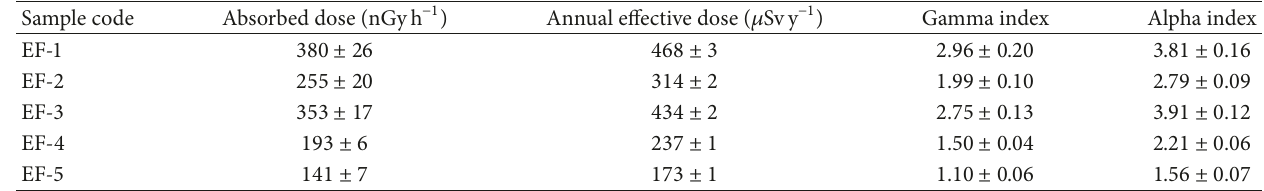
Table 5: Absorbed and annual effective dose and hazard indexes of fertilizers used in Egypt.